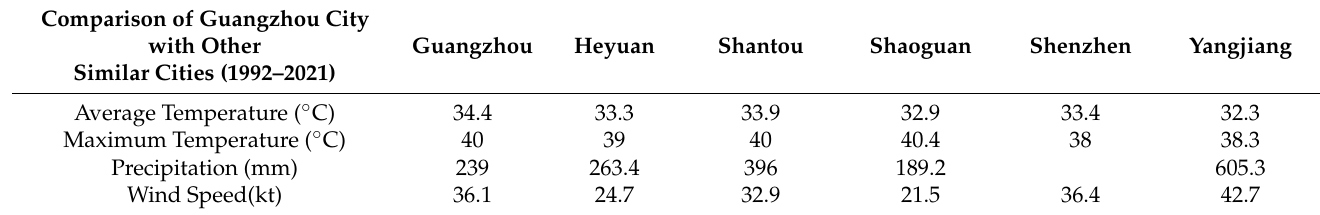
Table 2. Comparison of Guangzhou city with other similar cities for temperatures, precipitation and wind speed average values (1992–2021) for temperature.